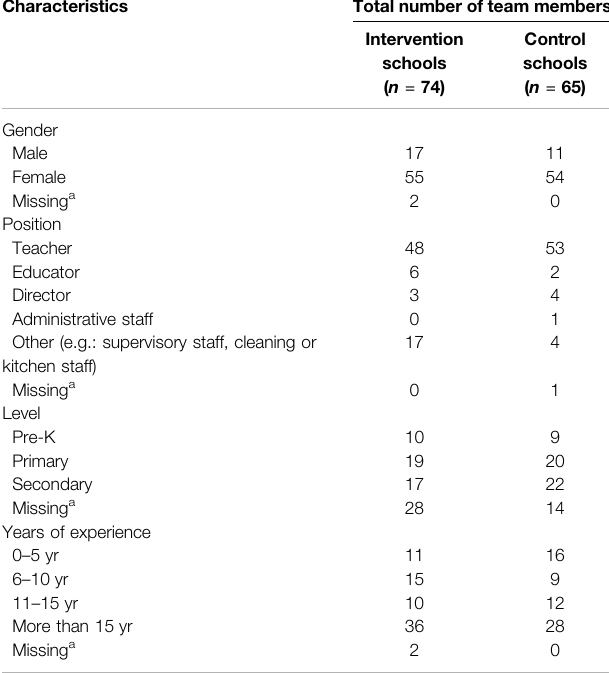
TABLE 1 | Demographic characteristics at